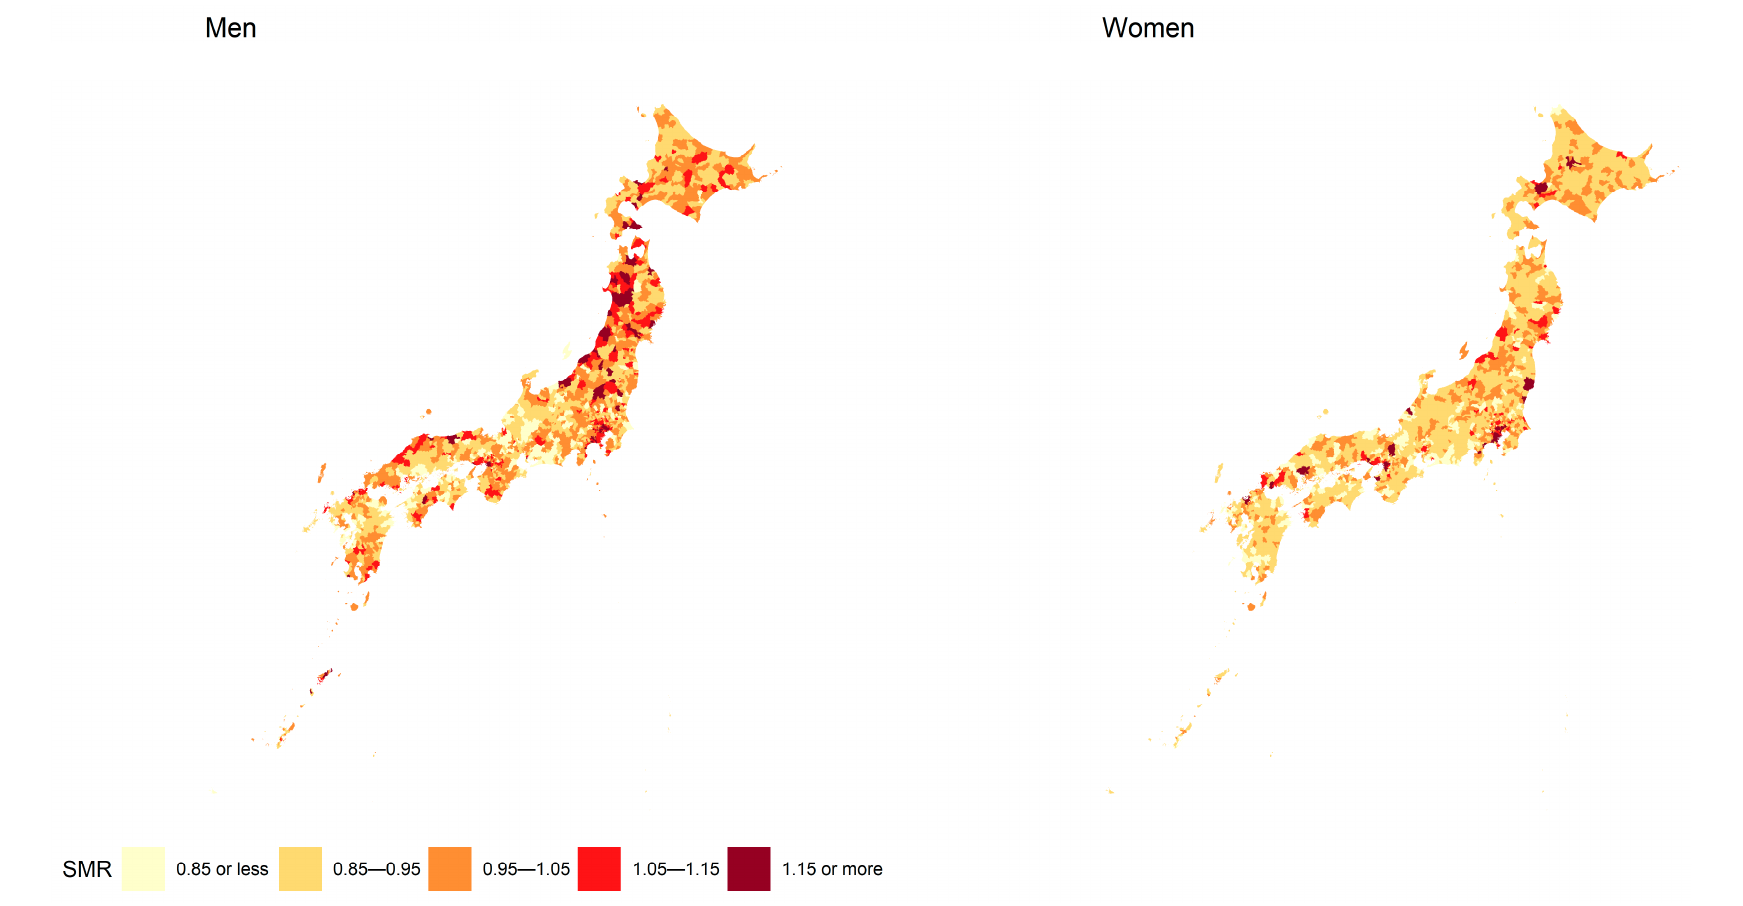
Figure 1. Geographic distribution of SMR of esophageal cancer for men and women. The left map indicates SMRs of men, and the right one indicates those of women.